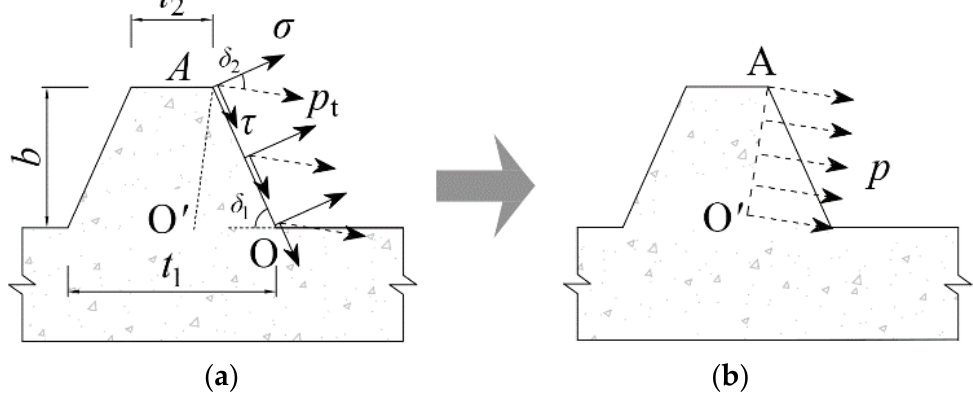
Figure 16. Forces on screw teeth. ( a ) Practical and ( b ) projection.